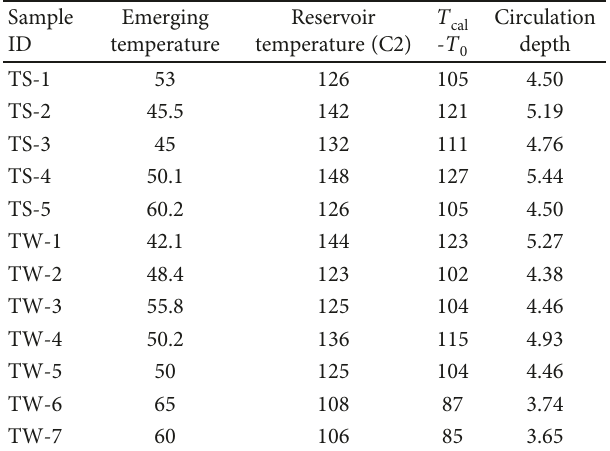
Table 5: Calculation results for circulation depth of geothermal water in the study area (temperature in ° C and depth in km).